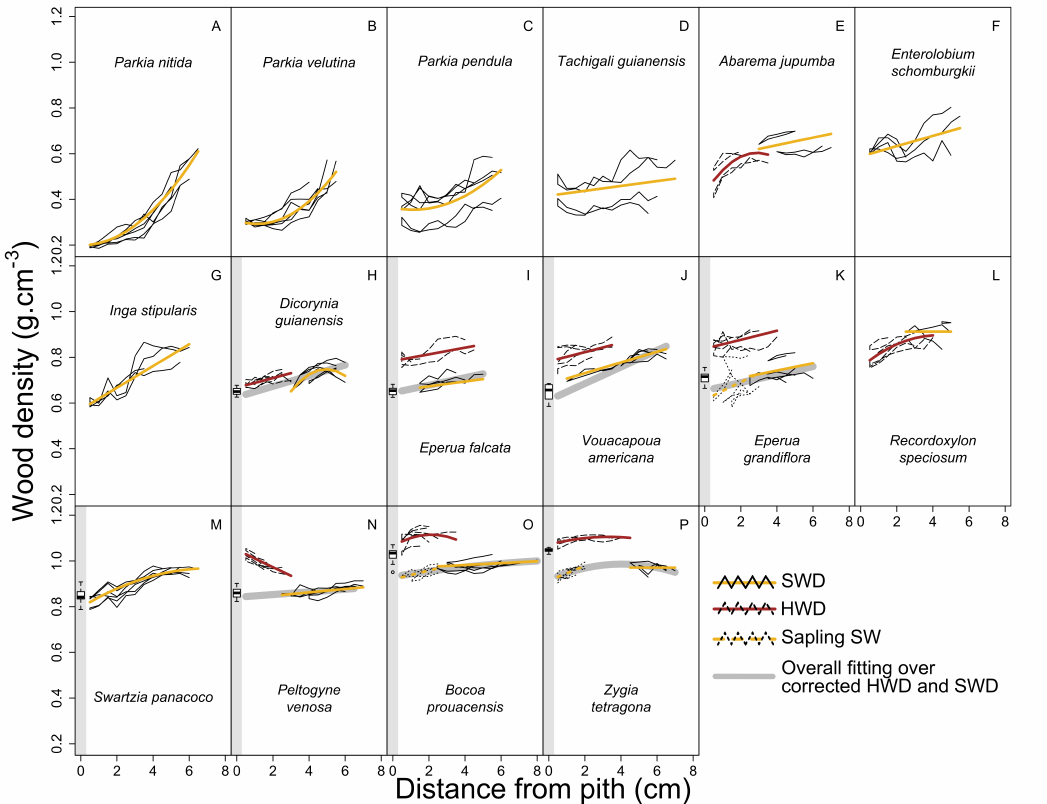
Figure 4. Modeling of radial patterns in wood density according to radial distance for heartwood free species ( A , B , C , D , F , G , M ) and for species with heartwood ( E , H , I , J , K , L , N , O , P ). Red and yellow solid lines represent the fixed effect of the best fit for heartwood and sapwood respectively. Yellow dotted lines represent the fixed effect of the best fit for the sapwood of the saplings (K, O, and P). Gray solid lines represent the best fit over corrected heartwood density and sapwood density. The whisker boxes on the left hand side of panels H, I, J, K, M, N, O, and P correspond to the range of corrected WD of the heartwood. Species are order from left to right and up to bottom by increasing average WD (as in Figure